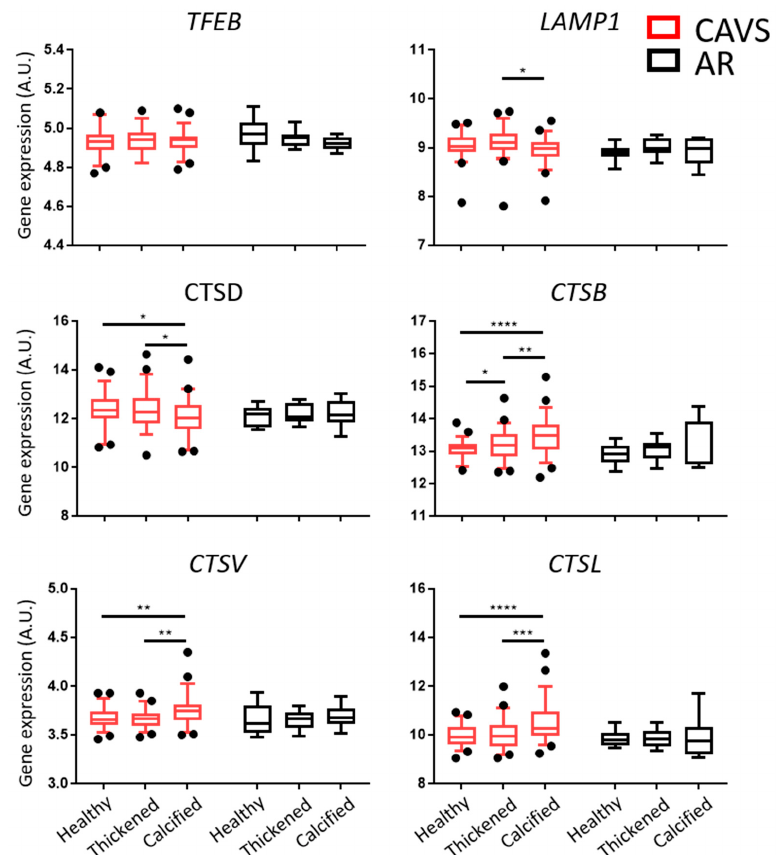
Figure 2. Lysosomal pathways are differentially regulated in the calcified tissue of human valves. Gene expression of key lysosomal genes in the healthy, thickened, and calcified tissue of human valves from calcific aortic valve stenosis (CAVS; n = 55) and aortic regurgitation (AR; n = 9) patients. Data presented as box-and-whisker plots with 5–95 percentiles. * = p < 0.05, ** = p < 0.01, *** = p < 0.001, **** = p < 0.0001.